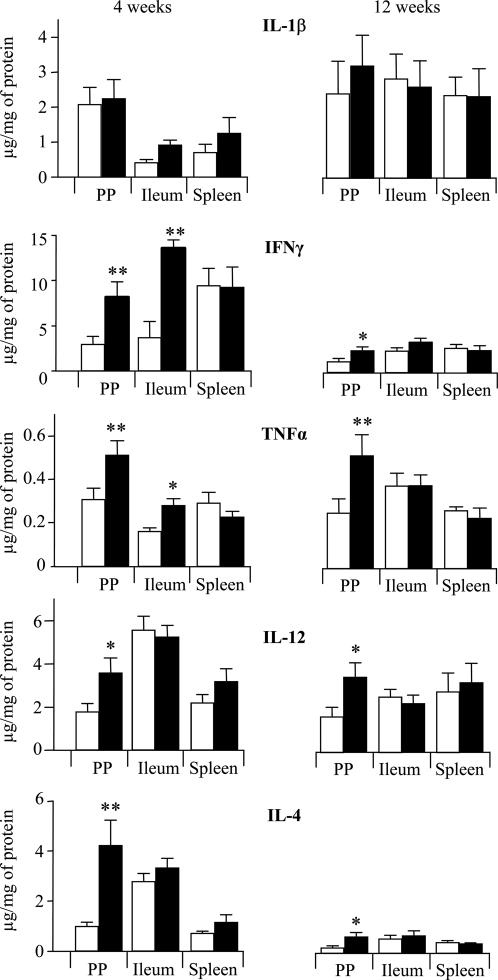

Nod2 invalidation increases cytokine expression in PP.Expressions of Il-1β, IFNγ, TNFα, IL-12, IL-4 were determined by ELISA in PPs, Ileum and spleens from KO (▪) and WT (□) mice at weeks 4 (left panel) and 12 (right panel). Data represent the means±SEM of 8 mice per group. *P<0.05; **P<0.01.